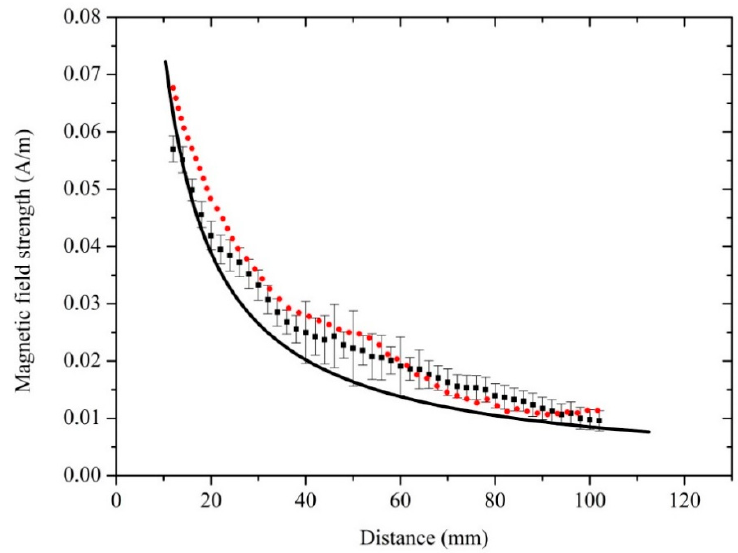
Figure 9. Verification results of distribution of microwave magnetic field strength. Dot line represents the simulated results of the distribution of the microwave magnetic field strength when the glass cell was inserted. The error bars on square solid spot represents the measurement uncertainty. The dot line was composed by a series of values, calculated by a series of simulation models. The frequency of electromagnetic wave was set at 9.19 GHz. We set the diameter of the column basal plane of glass cell to 20 mm, its height to 10 mm, and its thickness to 0.5 mm. The measurement distance was 52 mm. The magnetic field strengths were measured by changing the position of the Cs glass cell along the direction of o-x (showed in Figure 5c). The measurement distance was changed from 12 to 102 mm. The square solid spot represents the measured magnetic field strength, and the solid line represents the simulated field strength without the glass cell. They are consistent with the results showed in Figure 6. The variation trends of the three results were roughly identical. The simulated results of the microwave magnetic field strength when the glass cell was inserted are a little more than the simulated results in the free space at every measurement points. The measured results are much more approached to simulated results represented by the dot line.